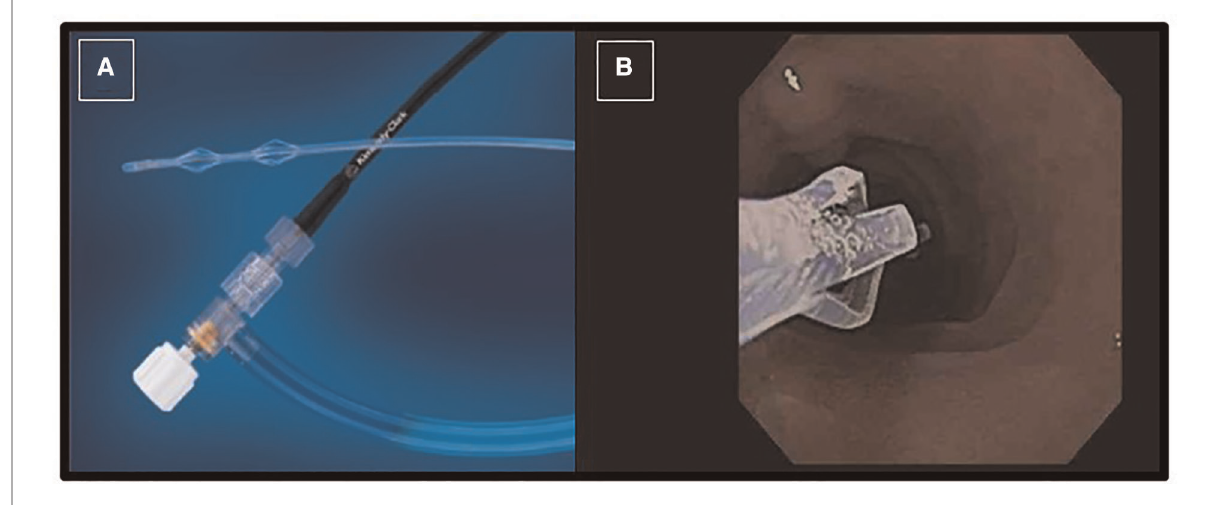
FIGURE 1 Picture of the collection catheter passed through endoscope working channel ( A ); the tip of catheter is seen in the duodenum close to the ampulla of vater ( B